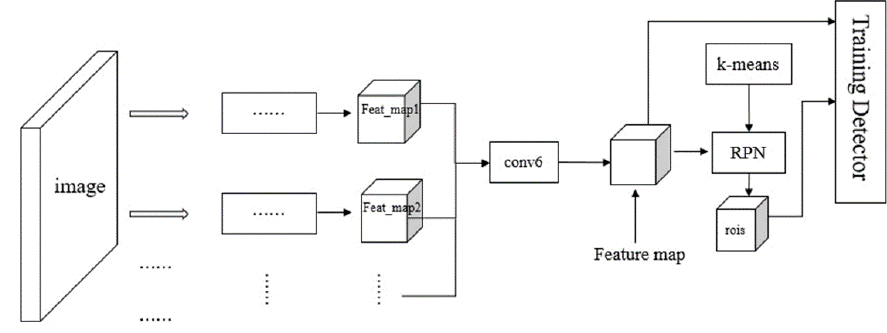
Figure 6. Framework of Multi-PerNet.